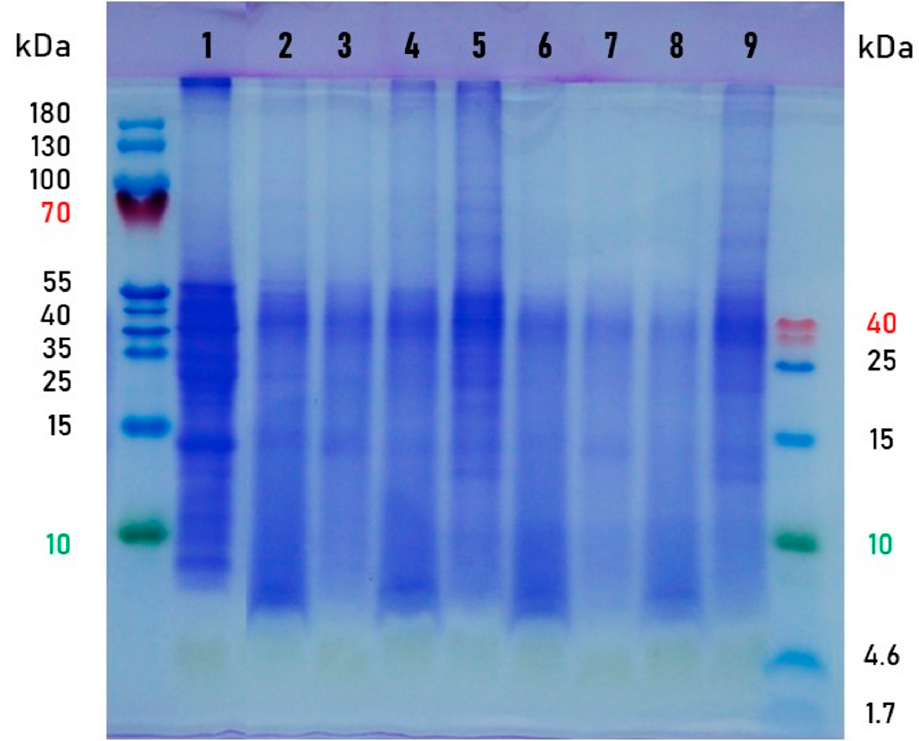
Figure 3. SDS-PAGE analysis of protein profiles in moringa leaves. Sample description: the dried leaves (1); the fermented leaves: Rhizopus oryzae —3 days (2) and 8 days (6), Rhizopus oligosporus —3 days (3) and 8 days (7), Aspergillus oryzae —3 days (4) and 8 days (8), Neurospora intermedia —3 days (5) and 8 days